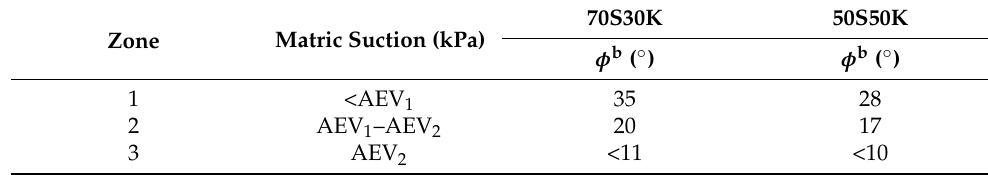
Table 6. φ b angle for different matric